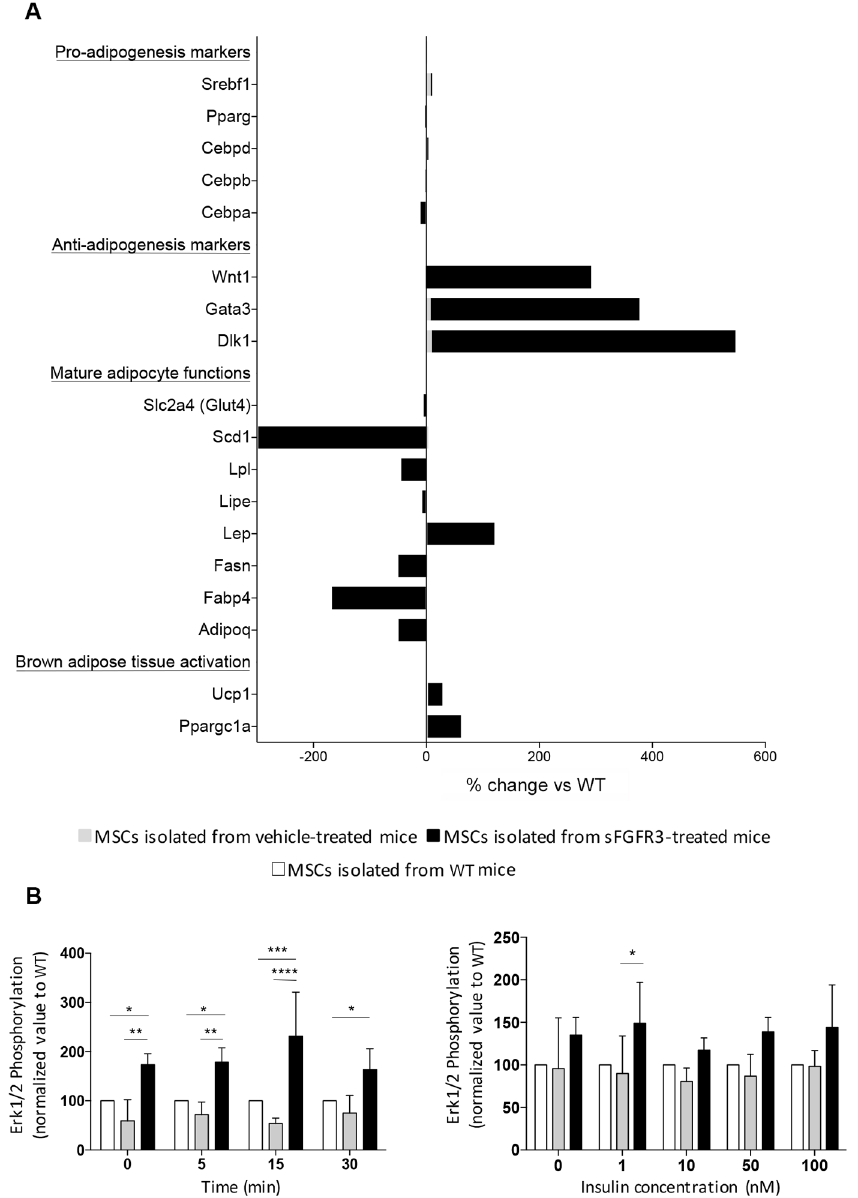
Fig 3. MSCs isolated from untreated or sFGFR3-treated Fgfr3 ach/+ mice show pre-engagement towards adipogenesis with no alteration of the insulin response compared to WT mice. (A) Expression of genes involved in different steps of adipogenesis differentiation (Genes are listed in S2 Table ). Expression was normalized to HPRT, RPL6 and RPL13a expression and expressed as percent of change compared to WT. ( B ) Cells were stimulated with 50nM of insulin for 0, 5, 15 or 30 min or with 0, 1, 10, 50 or 100nM of insulin during 5 min. P-Erk1/2 expression, normalized to Erk1/2 total expression, was expressed as normalized value to WT. Data are represented as mean ± SD. Data followed normal distribution. (cid:3) p < 0.05, (cid:3)(cid:3) p < 0.01, (cid:3)(cid:3)(cid:3) p < 0.001 versus vehicle-treated WT, # p < 0.05, ## p < 0.01 versus vehicle-treated Fgfr3 ach/+ ; Two-way ANOVA with Tukey’s multiple